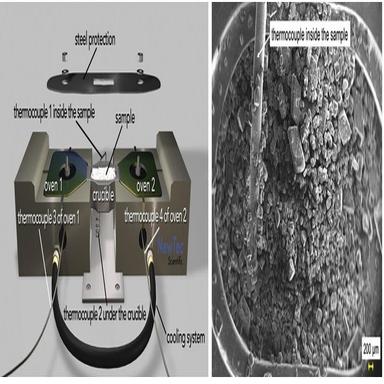
On the left, the hot stage used for the HT-SEM experiments made up of two ovens allowing applying either a homogeneous working temperature or a temperature gradient. A protection is added to avoid, as possible, the heat loss and the SEM chamber contamination, without avoiding the sample visual monitoring. On the right, top view of LiOH powder inside the HT-SEM stainless steel crucible.